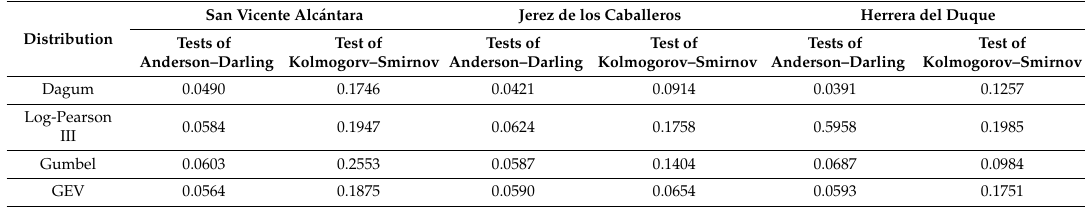
Table 2. Goodness-of-fit test results.